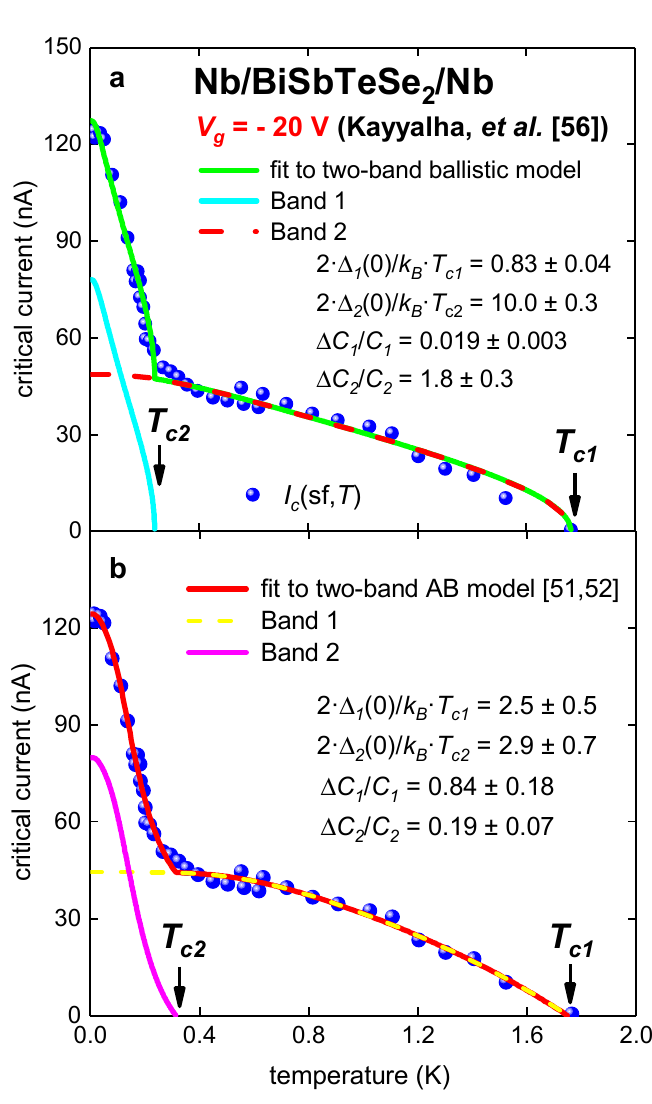
Figure 3. Experimental I c (sf, T ) for Nb / BiSbTeSe 2 -nanoribbon / Nb junction (Sample 1 [56]) at gate voltage V g = − 20 V. ( a ) Ballistic model, fit quality is R = 0.990; ( b ) modified AB model [51,52]. Derived parameters: R n1 = 6.7 ± 1.6 k Ω , R n2 = 0.75 ± 0.18 k Ω , fit quality is R = 0.9953. Table 3. Deduced parameters for Nb/BiSbTeSe 2 -nanoribbon/Nb junction (Sample 1 [56]) at V g = − 20 V from fit to two-band Titov and Beenakker (TB) [53] and Ambegaokar and Baratoff (AB) [7,8] models. Parameter TB Model